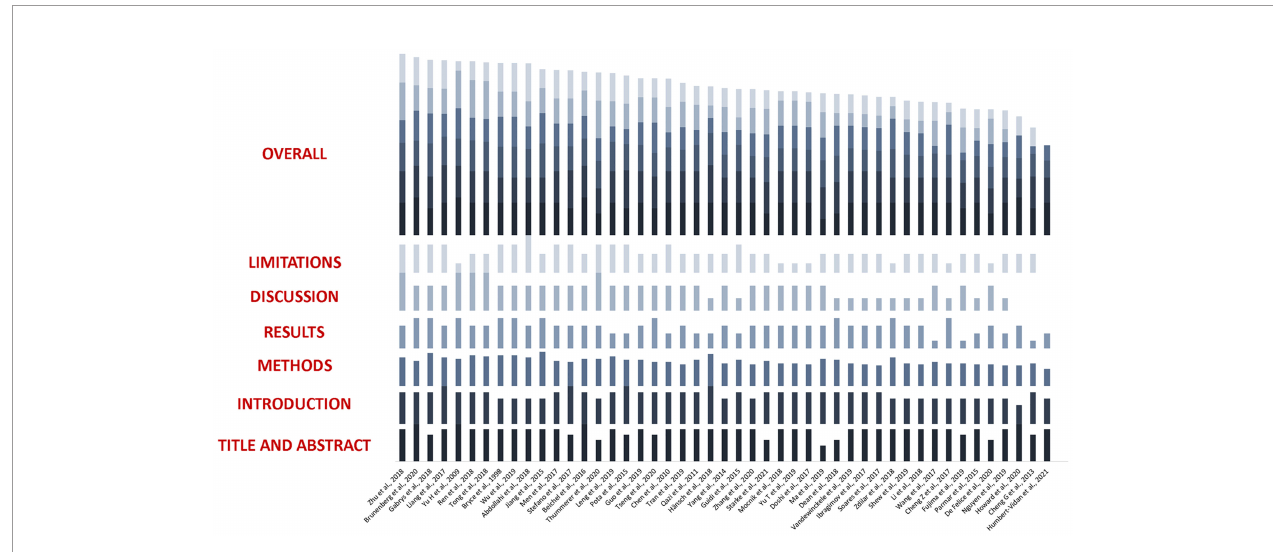
FIGURE 5 | Boxplots for global and methodological scores (modi fi ed Luo classi fi cation) for the studies included in the analysis, categorized according to imaging data used as input parameters (texture analysis vs. no texture analysis).